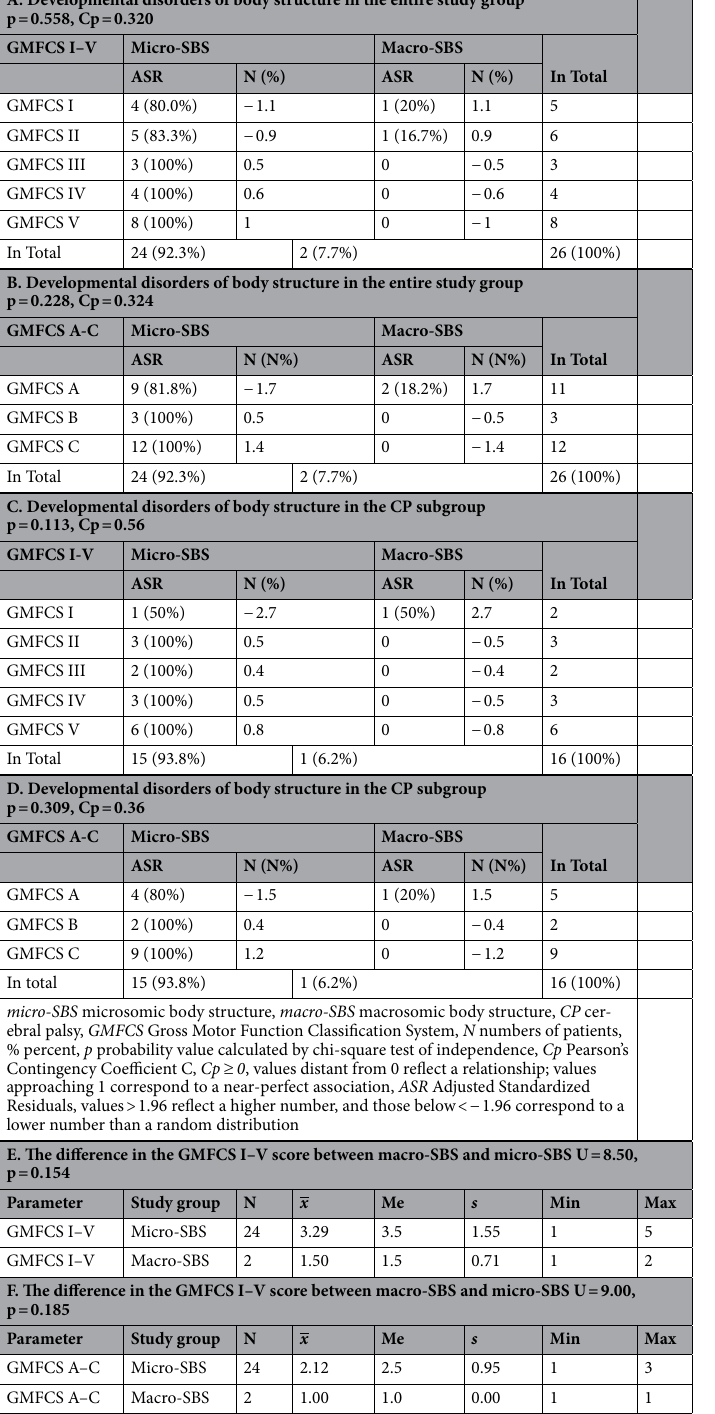
Table 4. Developmental disorders of body structure and: GMFCS I-V in the entire study group (A), GMFCS A-C in the entire study group (B), GMFCS I-V in the entire study group (C), GMFCS A-C in the entire study group (D). micro-SBS microsomic body structure, macro-SBS macrosomic body structure, U value of the Mann–Whitney U test, p test probability